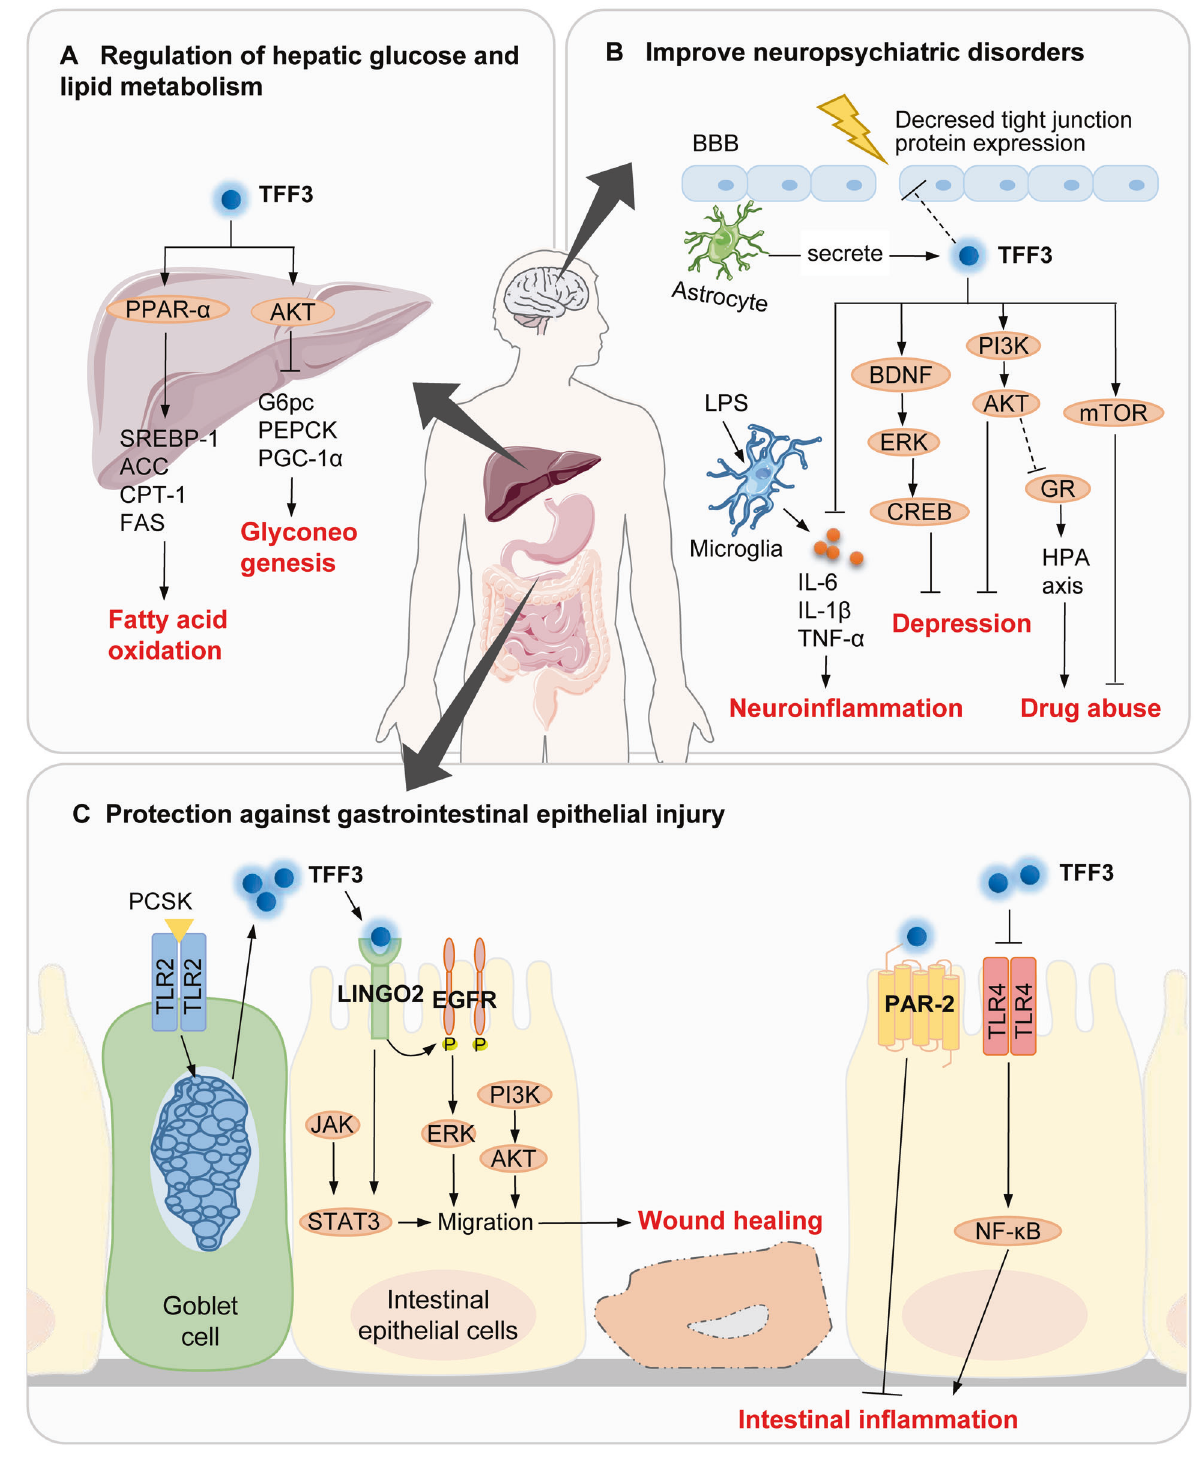
as early as day 2 after ulcer induction [52]; the level steadily increased at the ulcer margin after day 4 By 40 days, the TFF3 levels were elevated several hundred folds [53]. Animal studies have shown that TFF3 administration reduced gastric mucosal damage caused by alcohol, pylorus ligation, non- steroidal anti-in fl ammatory drugs, stress, and lipopolysaccharide (Table 4). Its effects include maintaining the gastric pH, stimulation of mucosal healing without proliferation [54], and